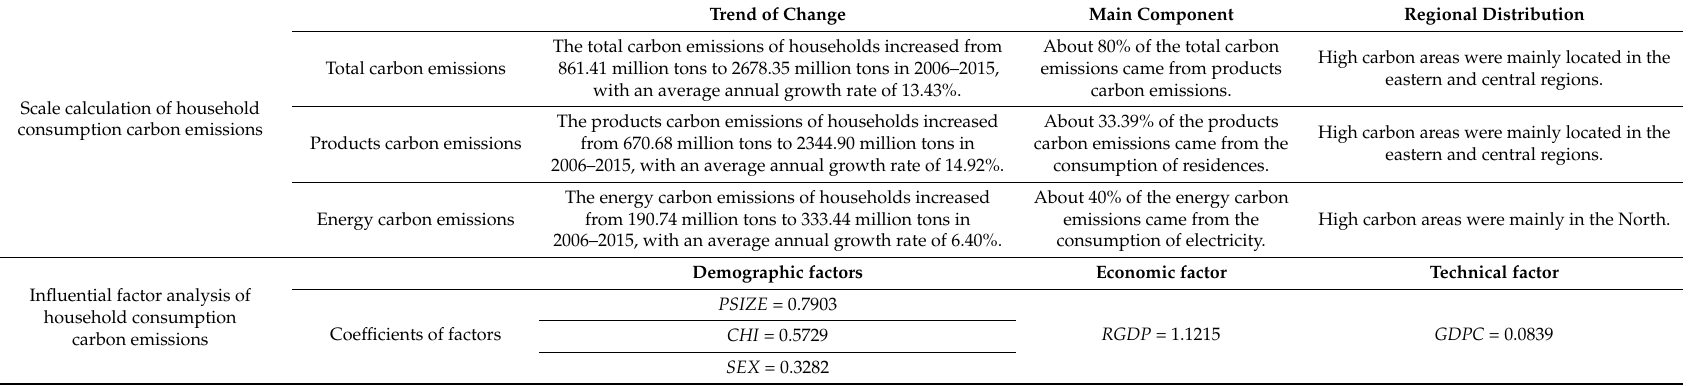
Table 8. Main conclusions of this